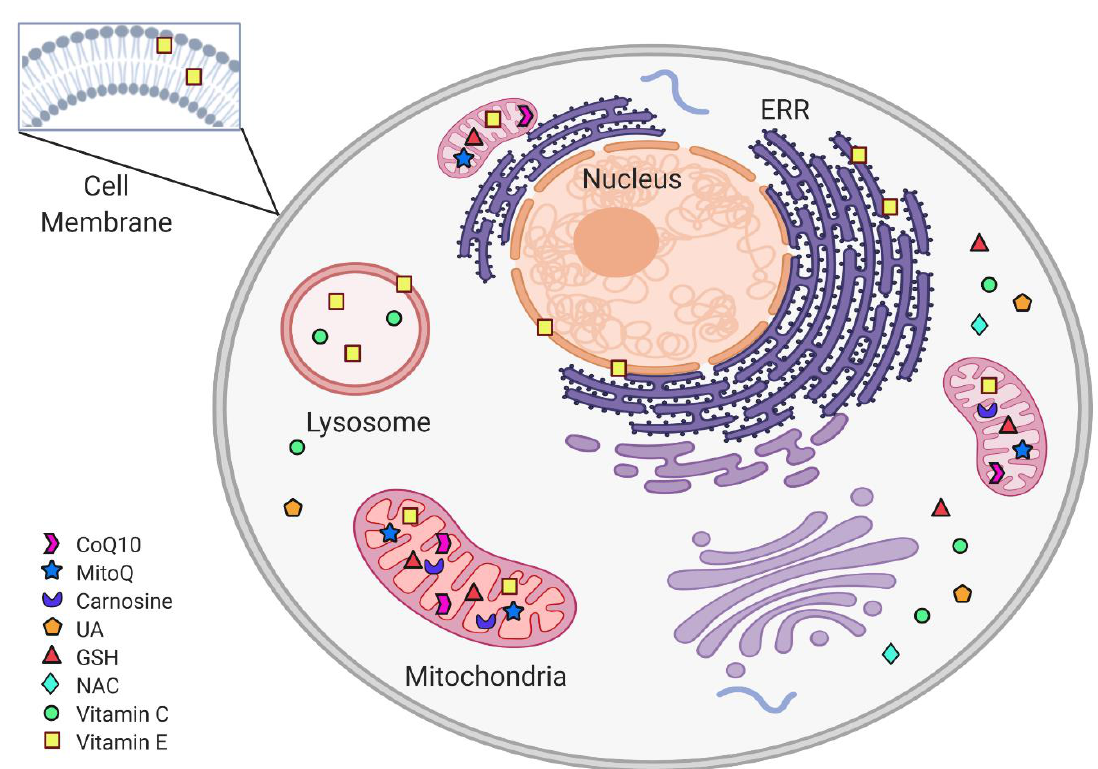
Figure 3. Subcellular non-enzymatic antioxidants targets. Within the cell, non-enzymatic antioxidants are distributed according to their subcellular target. The mitochondria are protected from oxidative stress by CoQ10, MitoQ, carnosine, and Vit C. In the cytoplasm, the antioxidant system includes GSH, NAC, and UA. Vit E is found in cytoplasmic, ERR, and mitochondrial membranes, as well as in lysosomes.